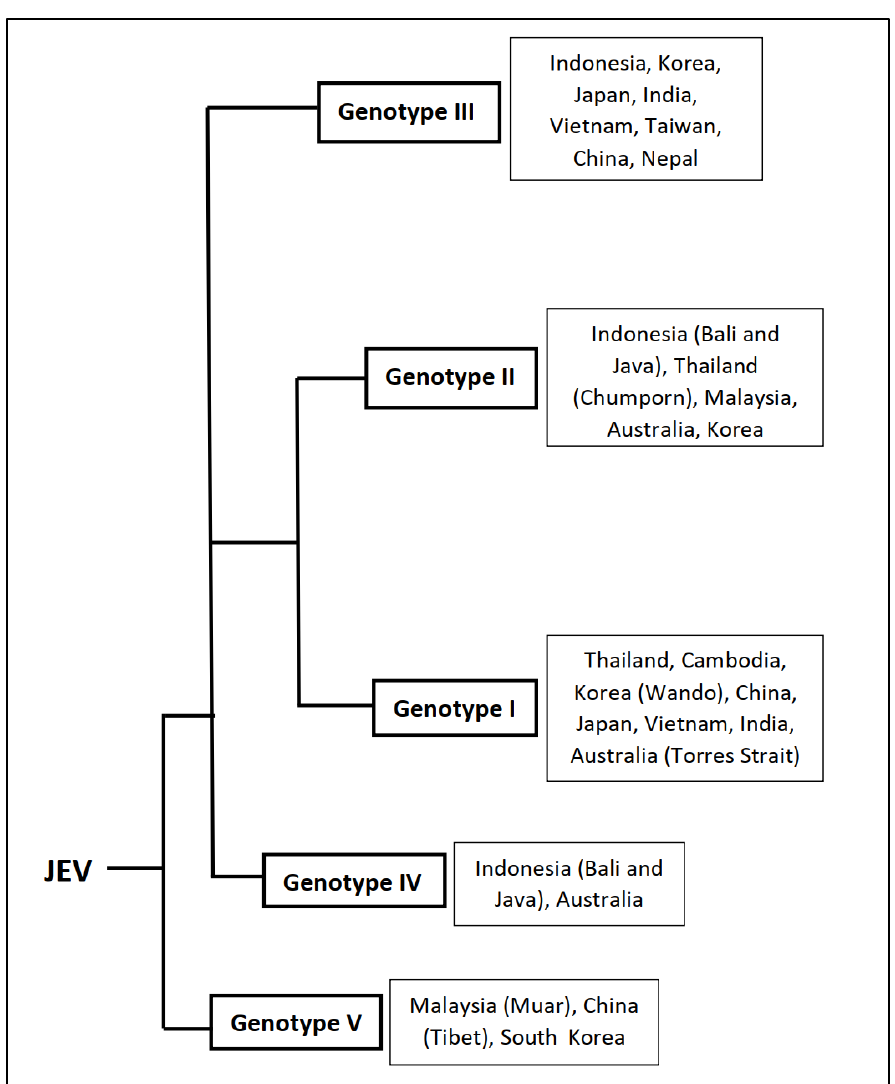
Figure 3. Genotypes of JEV and most affected countries. Based on the nucleotide sequences of the C/prM and E protein genes, JEV is classified into five genotypes as Genotype I, II, III, IV and V. A general representation of the origin of the various JEV genotypes, along with the countries/geographical areas where they are most abundant in or have the greatest impact (in the right side of the respective genotypes). The data represented is adapted from van den Hurk et al., 2022 [18], Gao X et. al, 2015 [31], Solomon T et. al, 2003 [32].